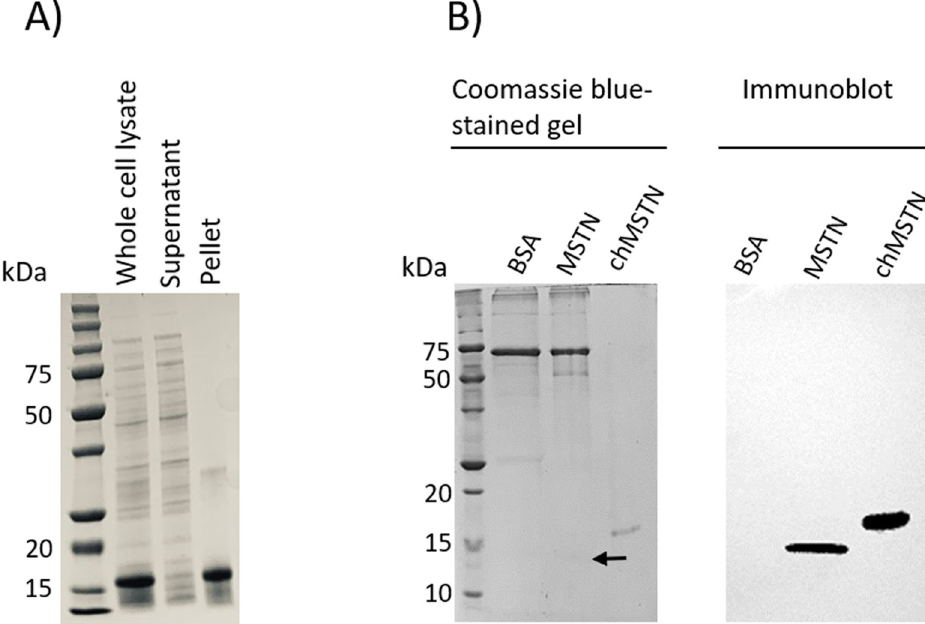
Fig 2. chMSTN antigen preparation. A) SDS-PAGE analysis of E . coli cell lysate after induction. The whole-cell lysate was centrifuged to separate supernatant and pellet, then the pellet was suspended in the same volume of PBS as the lysate volume. B) Western blot analysis of chMSTN. 300 ng of BSA (lane 2), 50 ng of commercial MSTN containing BSA as a carrier protein (lane 3), and 100 ng of solubilized chMSTN (lane 4) were subjected to SDS-PAGE and Western blot analysis. Monoclonal anti-MSTN antibody (0.34 mg/mL) was used as a primary antibody (1:500) and peroxidase-conjugated goat anti-mouse IgG (H+L) was used as a secondary antibody (1:20,000). The arrow indicates a faint MSTN